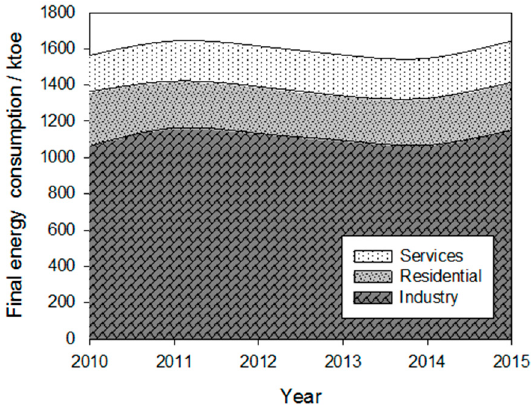
Figure 7. Natural gas for final energy consumption in Portugal by activity sector from 2010 to 2015 (data taken from [27]).